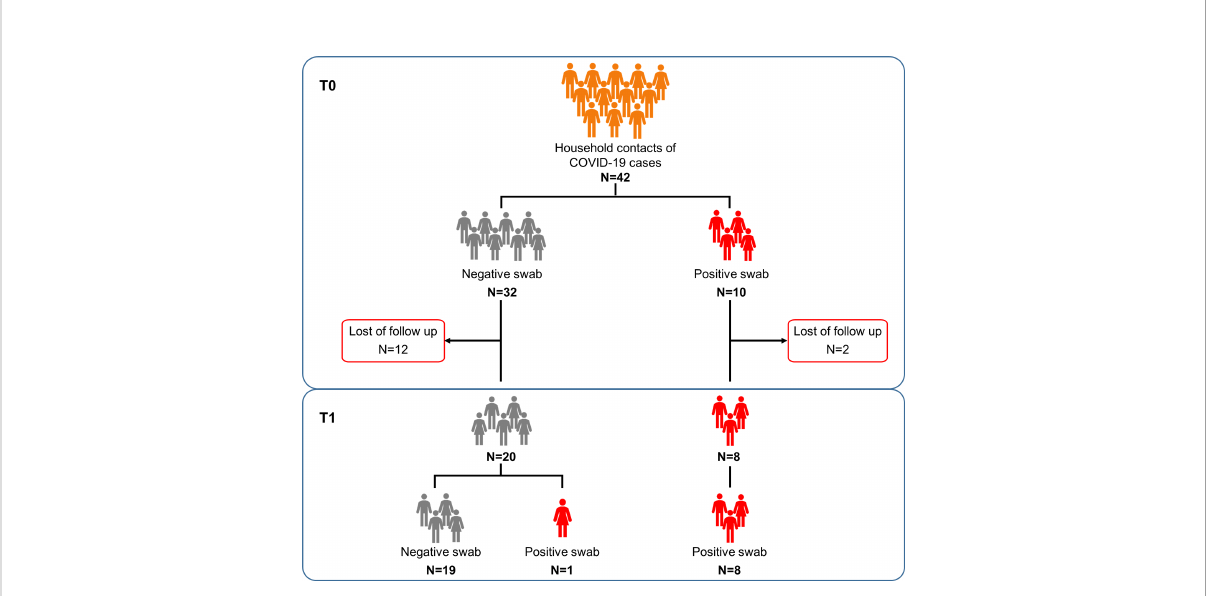
FIGURE 1 Flow chart of the enrolled household contacts of COVID-19 cases. Household contacts of COVID-19 cases (n=42) were enrolled and analyzed at the execution of the fi rst nasopharyngeal swab (T0) and after 7-20 days (T1), at the end of the quarantine period. Twenty-eight of these subjects returned to follow-up. Footnote: COVID-19, COronaVIrus Disease